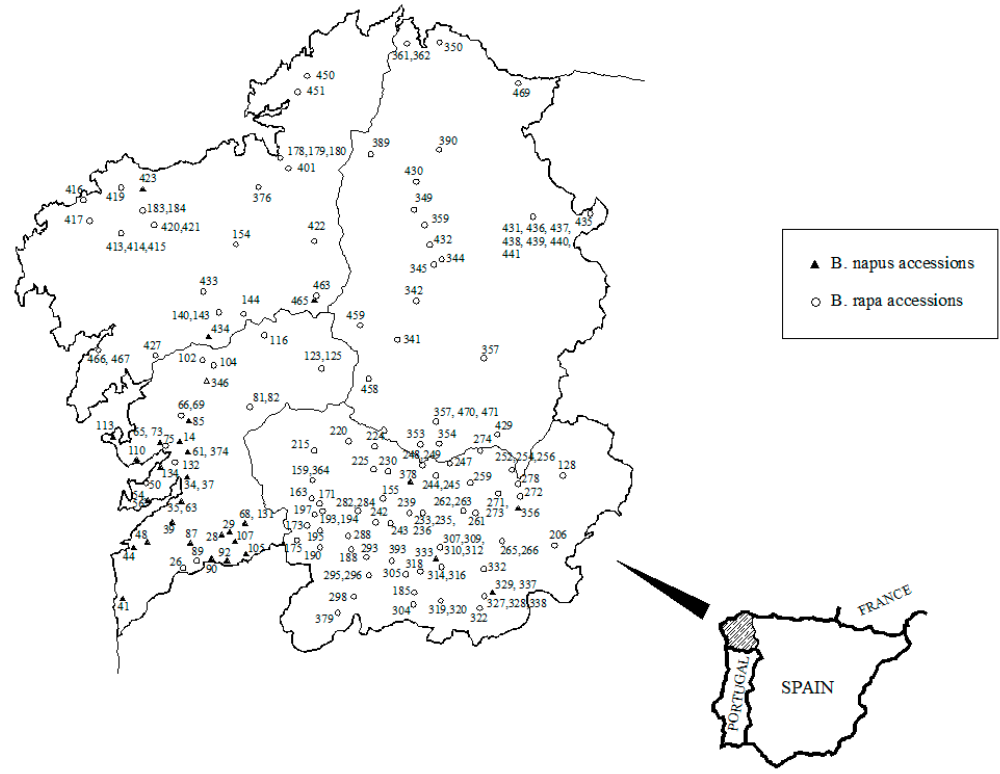
Figure 1. Map of Galicia (northwestern Spain) with the geographical distribution of the B. rapa and B. napus landraces evaluated in this study.